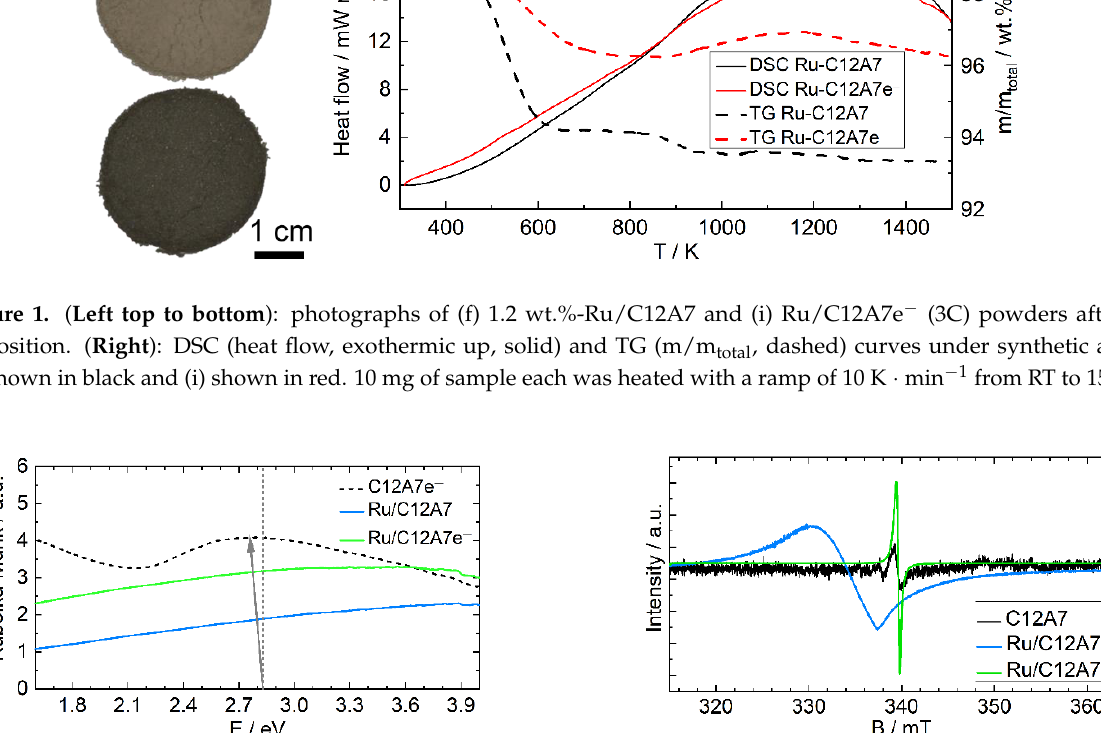
Figure 2. Left : Kubelka–Munk-transformed DRUVVis spectra for Ru-impregnated samples: blue (g) Ru/C12A7, green (i) Ru/C12A7e − (3C) and dashed (d) C12A7e − (3C). The dotted line at 2.83 eV corresponds to the absorption peak maximum for N e = 1 · 10 18 cm −3 [21]. The arrow indicates the shift with increasing N e . Right : first derivative EPR spectra for samples (a) C12A7 (black), (f) Ru/C12A7 (blue) and (i) Ru/C12A7e − (green) samples, intensities are not normalized.